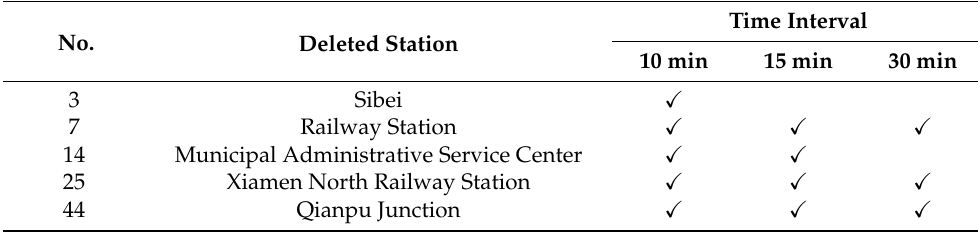
Table 6. Station classification results in the Xiamen BRT in 15 min time interval. Categories Table 7. The deleted stations in the different time intervals in the Xiamen